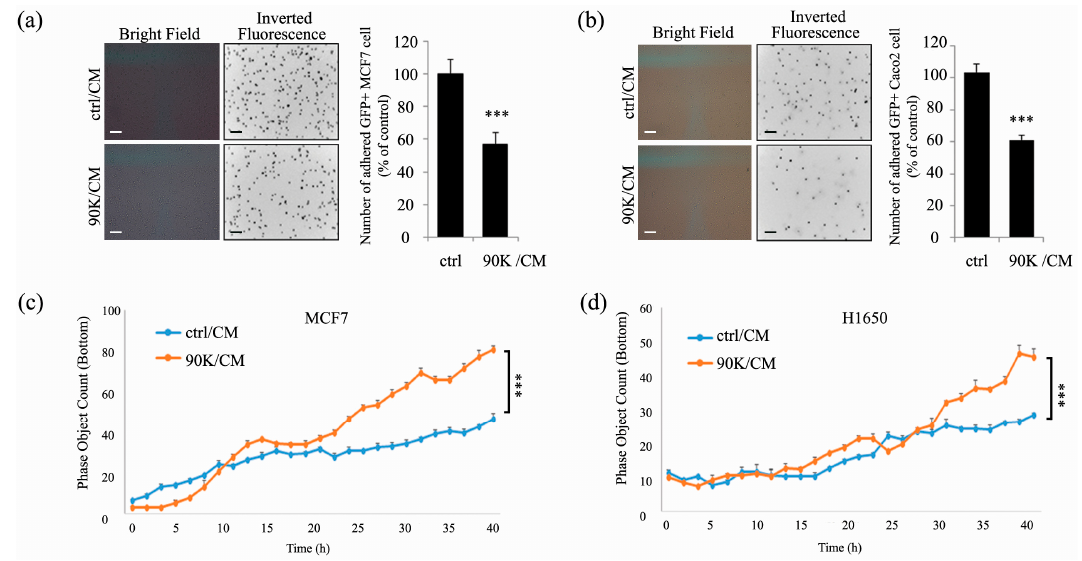
Figure 3. 90K decreases adhesion and increases invasion of subconfluent cancer cells. ( a , b ) Cell–cell adhesion was decreased by 90K. Cell–cell adhesion was allowed for 1 h with MCF7 ( a ) and Caco2 ( b ) cells. Cells plated on 30% confluence were treated with either ctrl/CM or 90K/CM for 16 h and, then, stained with Calcein green prior to addition into the well where the non-stained confluent cells were plated. A quantity of 3 × 10 5 stained cells were added into the cell-coated well. Adherent Calcein green-positive cells were photographed by fluorescence microscopy and inverted grayscale images from fluorescence picture are shown. Quantitations of the cell number are shown in the right panel. Scale bar, 100 µ m. ( c , d ) Invasive potential of the cells was increased by 90K. Invasion assay was performed with subconfluently plated MCF7 ( c ) and H1650 ( d ) cells treated with either ctrl/CM or 90K/CM. Invaded cells at the bottom of transwell chamber were monitored using a live-cell imaging device (IncuCyte) with a real-time check for the subconfluency of the upper chamber cells, and time-course analyses of the invaded cell number are shown. Values are presented as mean ± SEM. *** p < 0.001 compared to control group.